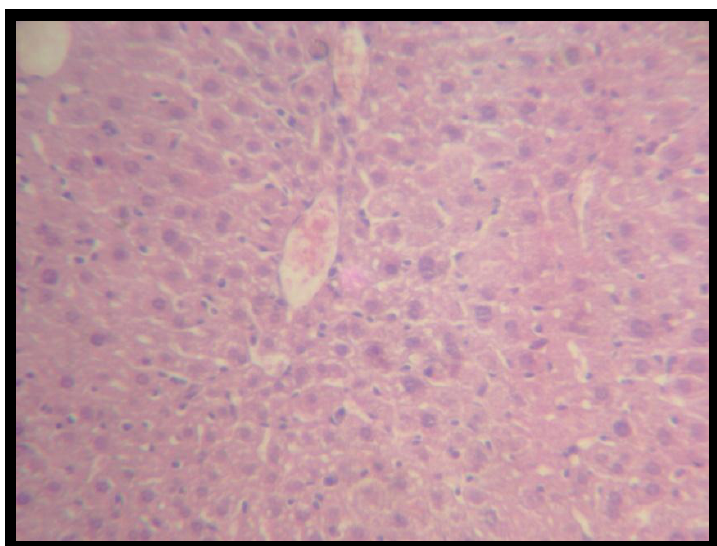
Fig. 2: Histopathological section of control male Mice show normal structure of the testis (H & E